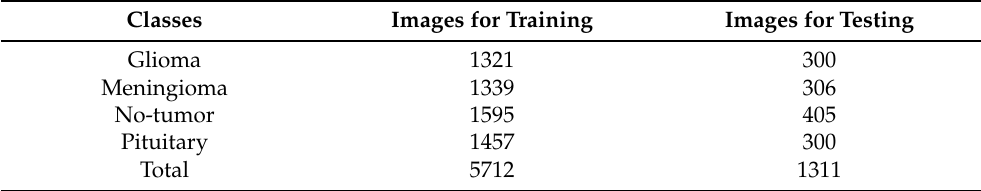
Table 4. Dataset details.